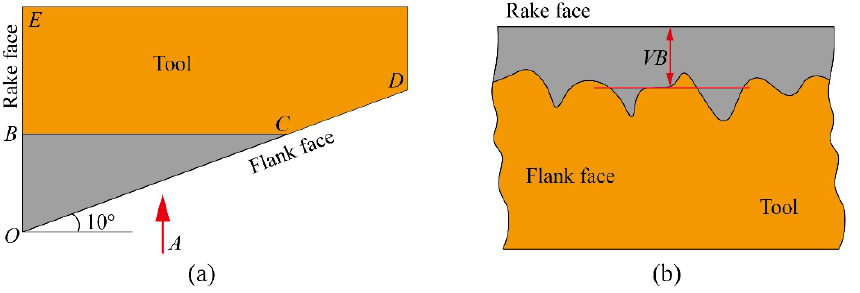
Figure 2. Schematic illustration of tool wear. ( a ) Tool wear cross section, ( b ) A-direction view. Response surface method was used to design the simulation experiment, which could obtain the influence of experiment parameter on results and its significance. Combined with engineering experience, four cutting parameters with five different levels of each were studied in the simulation experiment. The factors level of spindle speed ( n ), feed rate ( v f ), radial depth of cut ( a e ), and axial depth of cut ( a p ) are shown in Table 3. The cutting force ( F ), tool flank wear ( VB ) and material removal rate ( Q ) were as the response performance indicator.